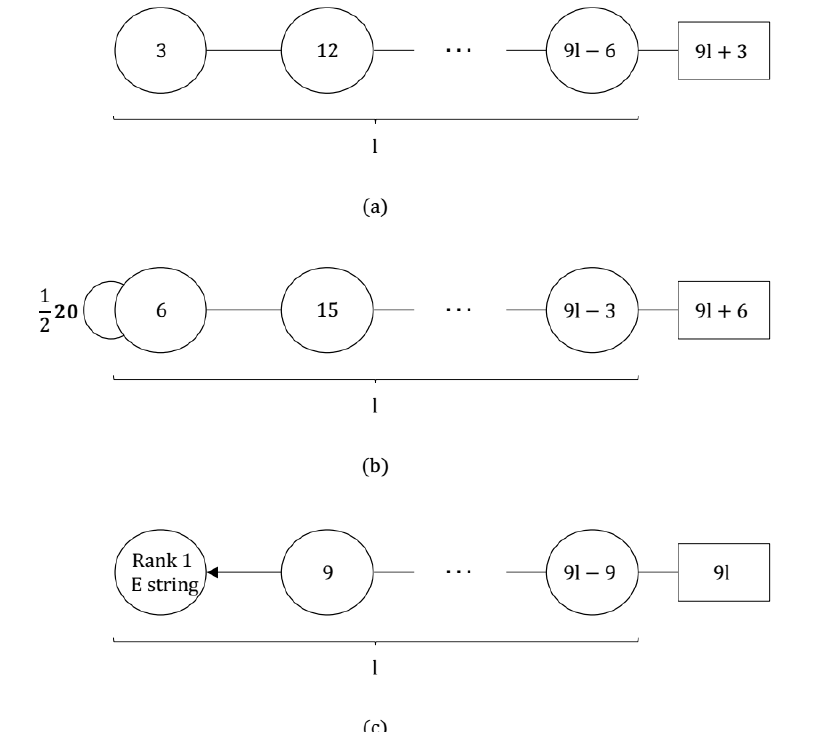
Figure 5 . Quivers of 6 d gauge theories which are the low-energy tensor branch descriptions of certain 6 d SCFTs. Here all gauge algebras are of type su